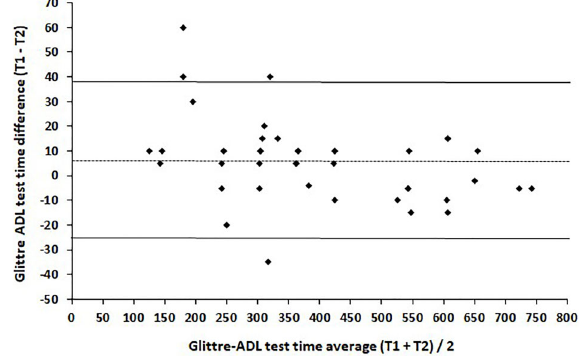
Figure 2. Bland-Altman plot for the total time between the 2 tests (T1 and